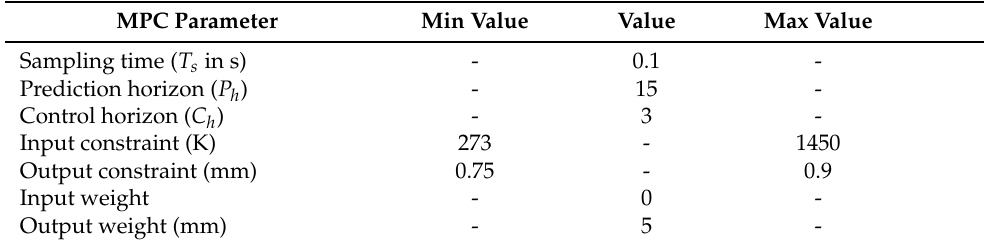
Table 5. MPC parameters for layer height